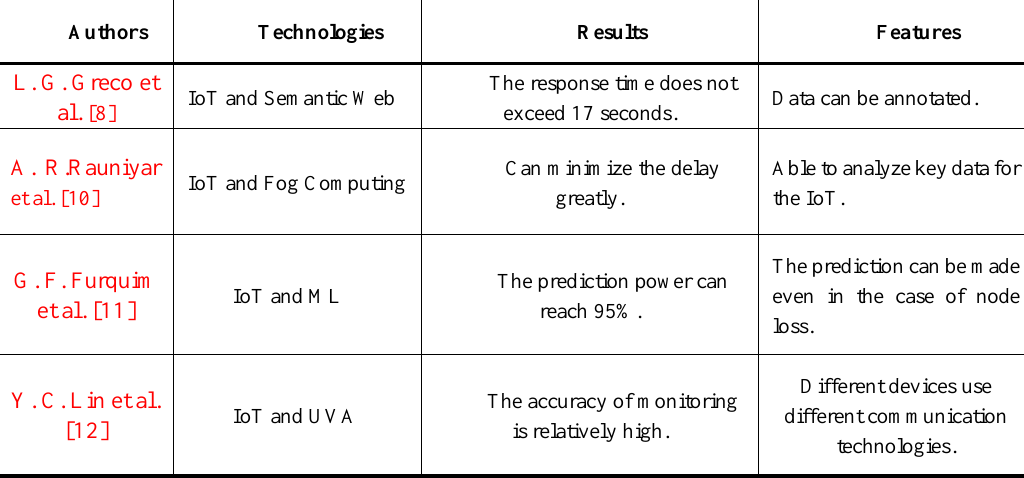
Table 1. The comparison of IoT and other technologies for disaster